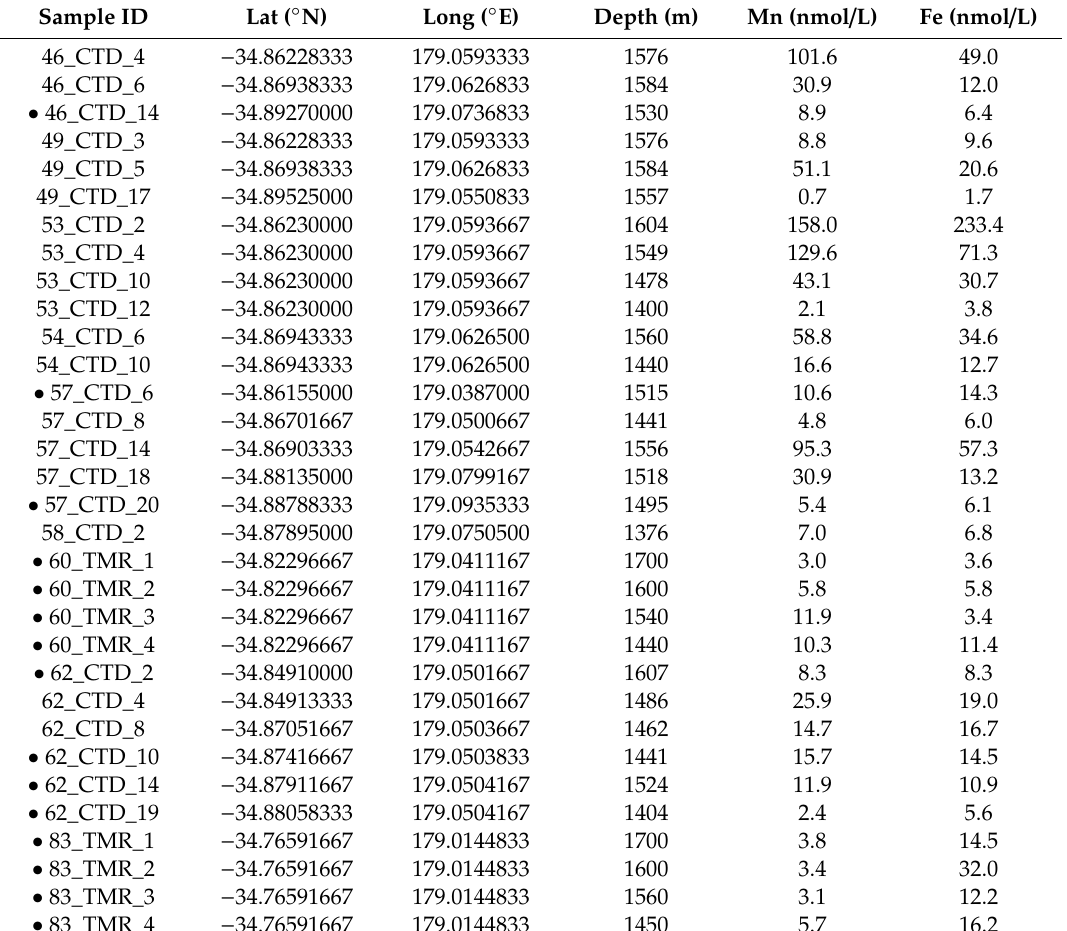
Table A1. Dissolved trace metal concentrations for Fe and Mn of hydrothermal plume samples in the depth range 1350–1700 m at Brothers volcano which were used in Section 4.4 for the calculations. The prefix ( • ) indicates samples taken outside of the caldera. The overall error of analysis was 5